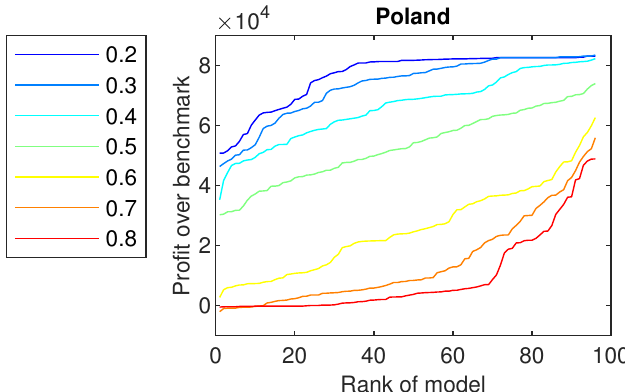
Figure 3. Profits achieved by probit models for the Polish data, ranked from the worst to the best, for different threshold